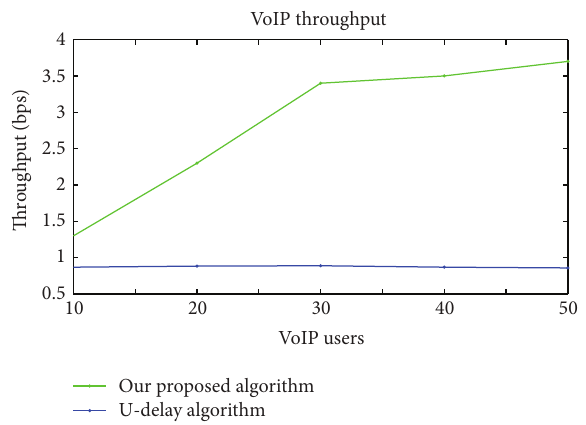
Our proposed algorithm U-delay algorithm Figure 11: VoIP throughput of our proposed algorithm VS U-delay in